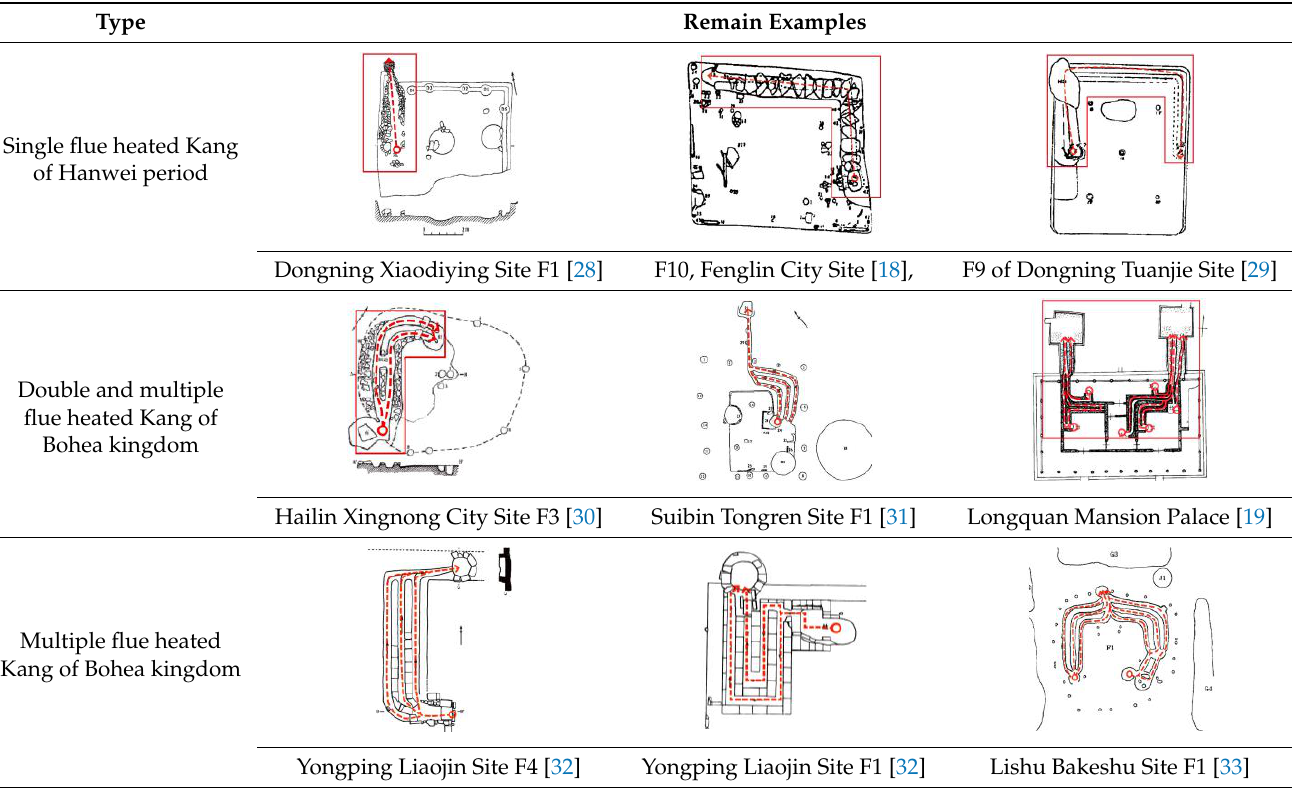
Table 6. The heated kang relics of different periods in the Amur river basin [28–33].